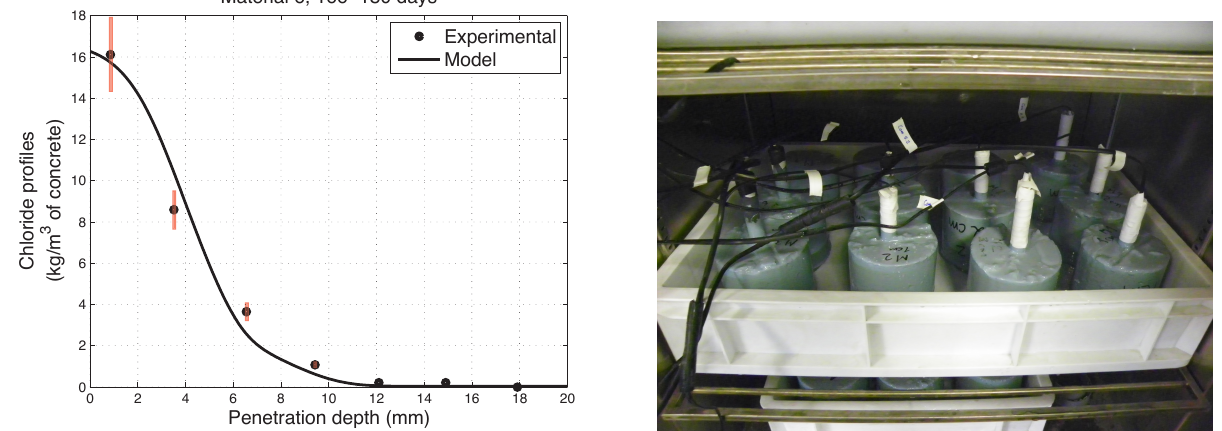
Figure 10. Left : experimental versus numerical solution for material mat6 and environment 5 (166–180 days). Right : measurements of the relative humidity within the concrete